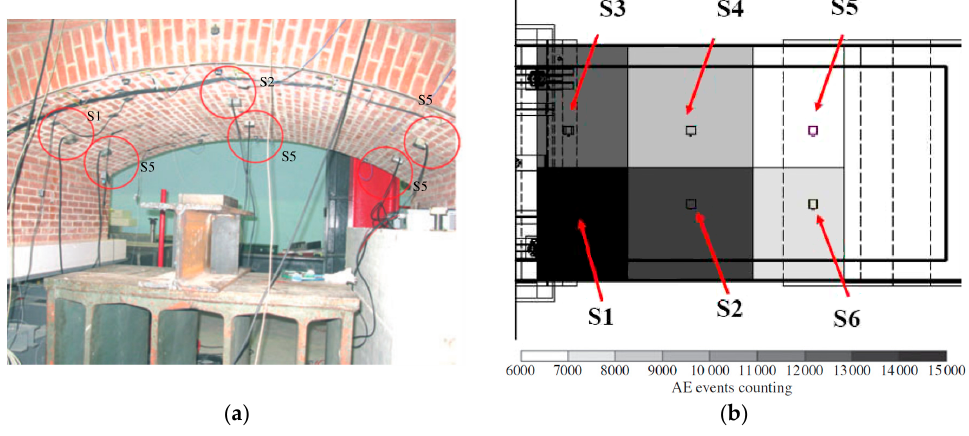
Figure 10. ( a ) Placing of the acoustic emissions sensors, and their competence areas; ( b ) number of acoustic events in each competence area.